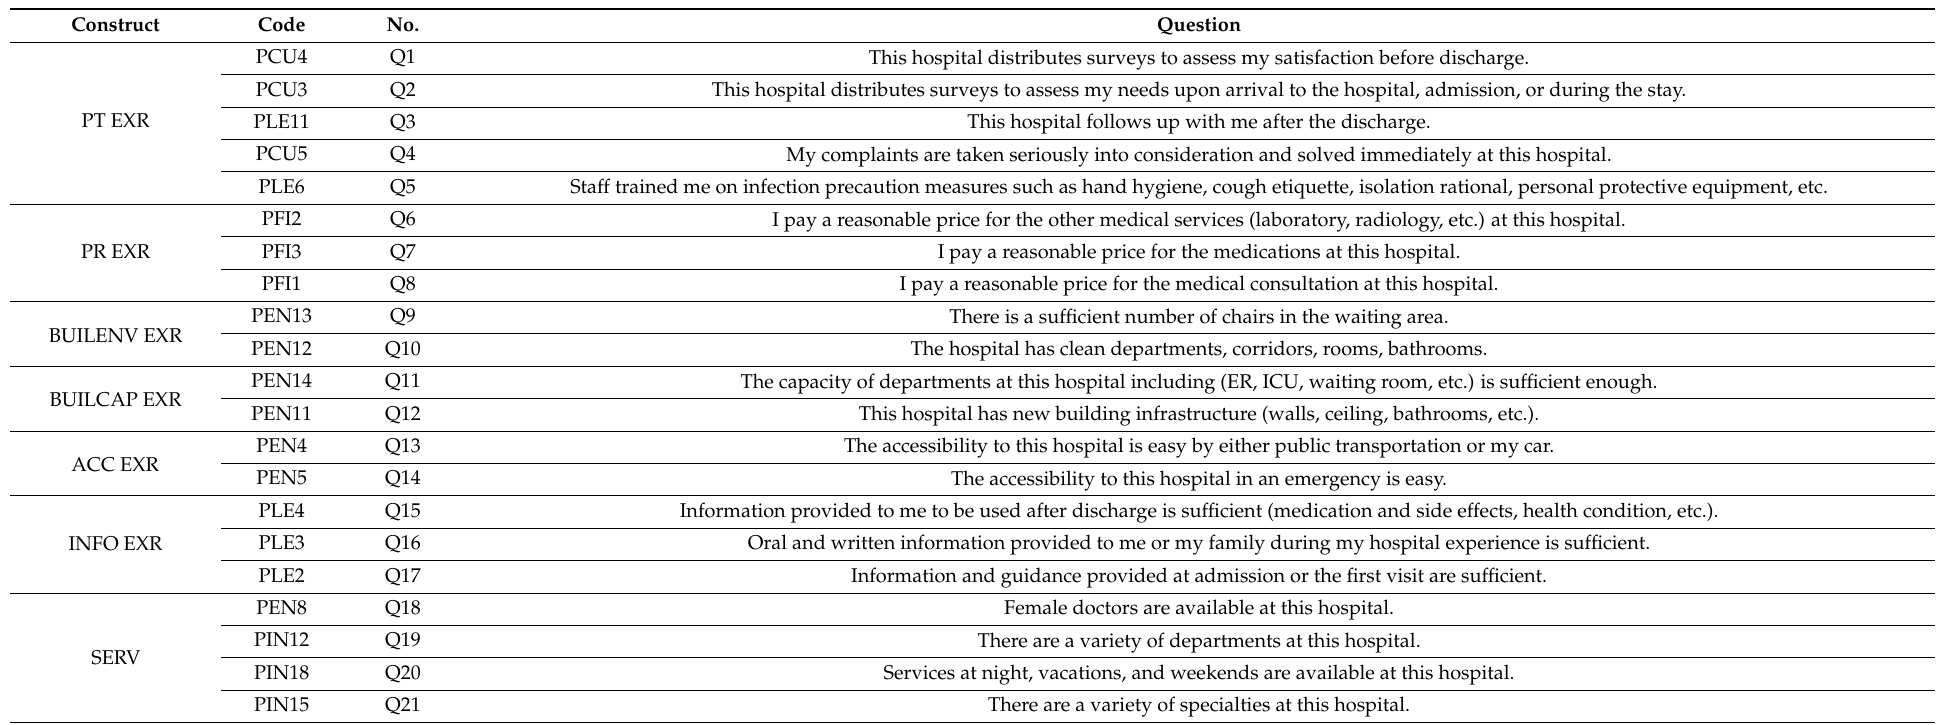
Table A3. Final resulted